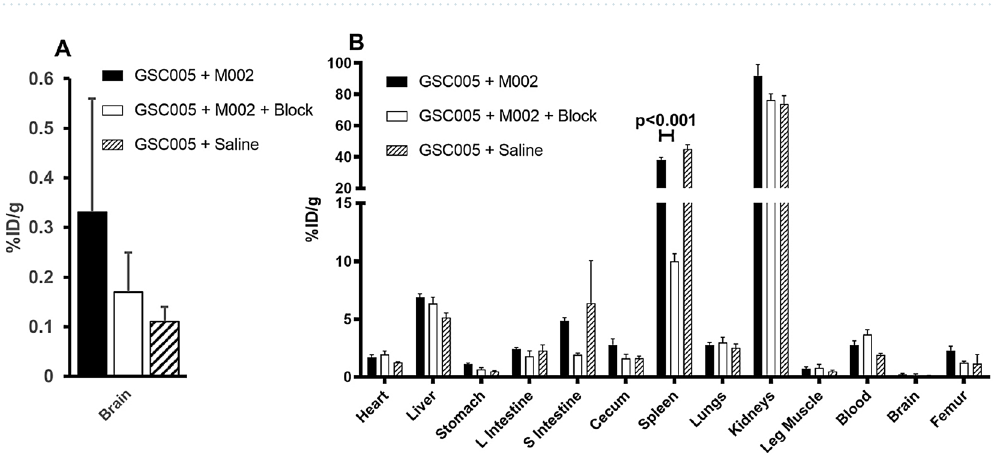
Figure 4. Biodistribution of [ 89 Zr]-malDFO-169 cDb shows receptor-mediated accumulation in the spleen. ( a ) Ex vivo biodistribution data at 24 h shows uptake of activity in the whole brain was highest in the GSC005 + M002 group relative to the other groups. ( b ) Normal tissue biodistribution data at 24 h shows high uptake in the spleen and kidneys and low uptake in the brain. Splenic accumulation can be blocked by the co-administration of nonradioactive CD8 cys-diabody. Data in both graphs is presented as group mean values and standard deviation. Graphs were generated using Microsoft Excel version